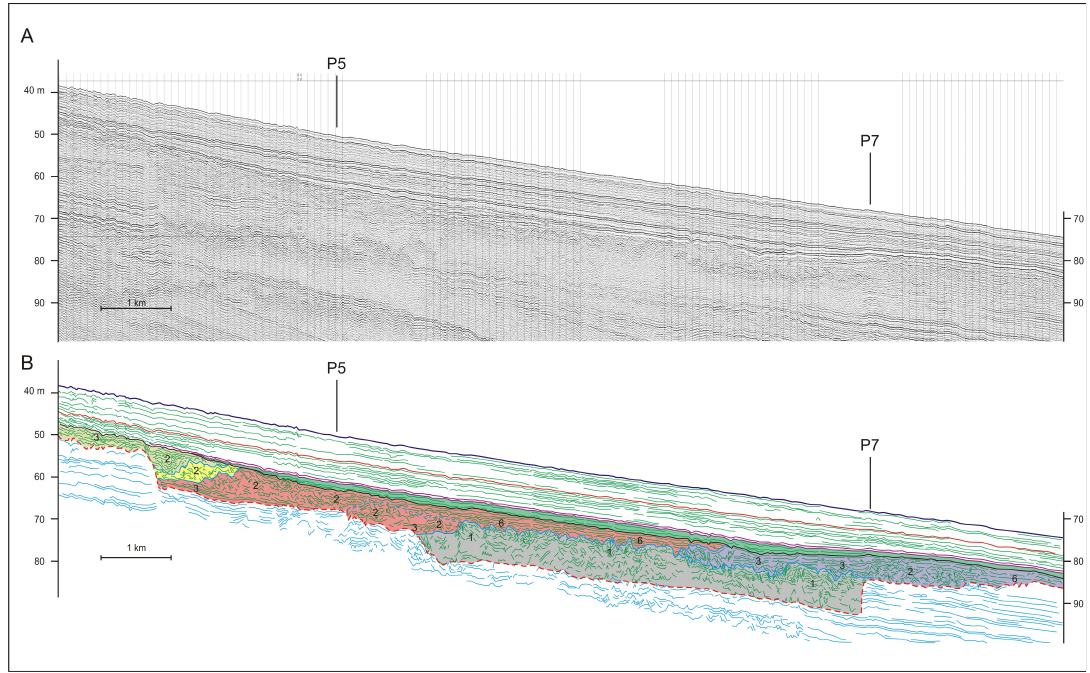
Figure 9. Part of seismic profile T2. Seismic section ( A ) and interpretation ( B ) showing, among others, the Ofanto valley (OV) with thick basal infilling by unit BU1 l and units A l , B m , C m , and D